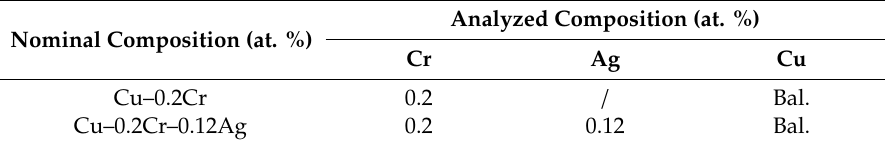
Table 1. Chemical compositions of studied alloys. Analyzed Composition (at. Nominal Composition (at. %)